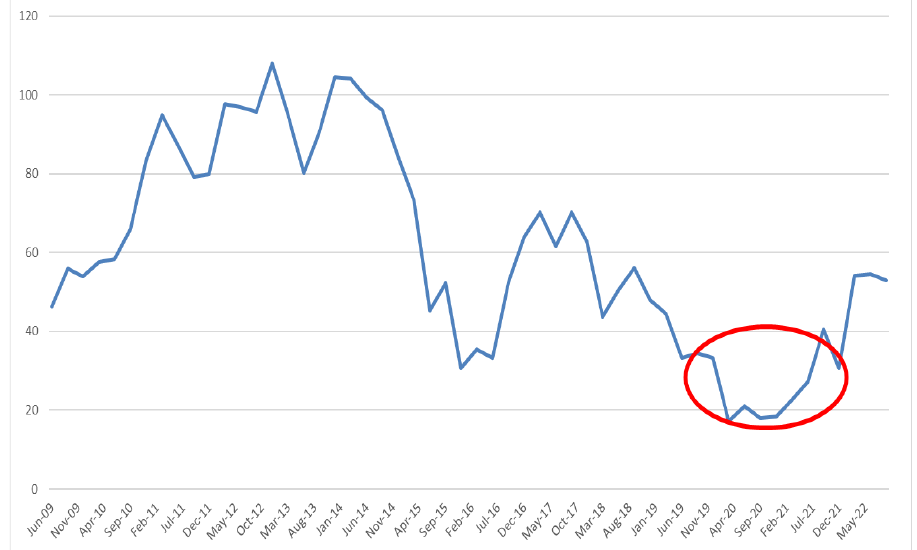
Figure 11. LW Bogdanka S.A. share prices.